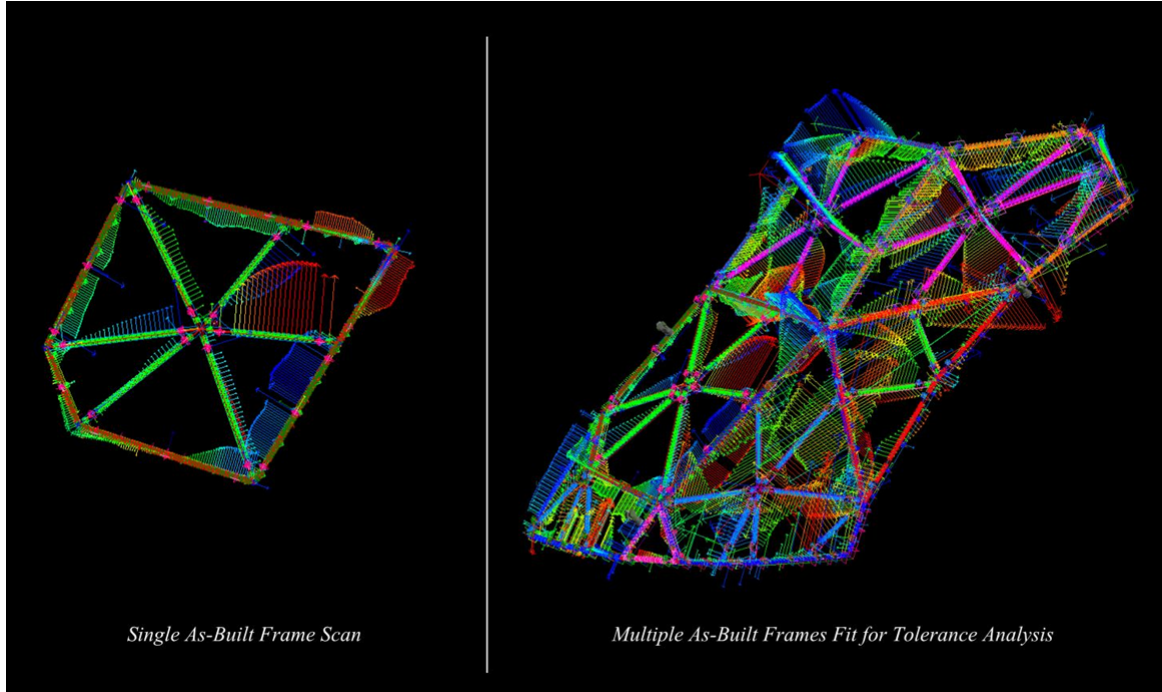
Fig. 11 Digital Model of As-Built “Mega